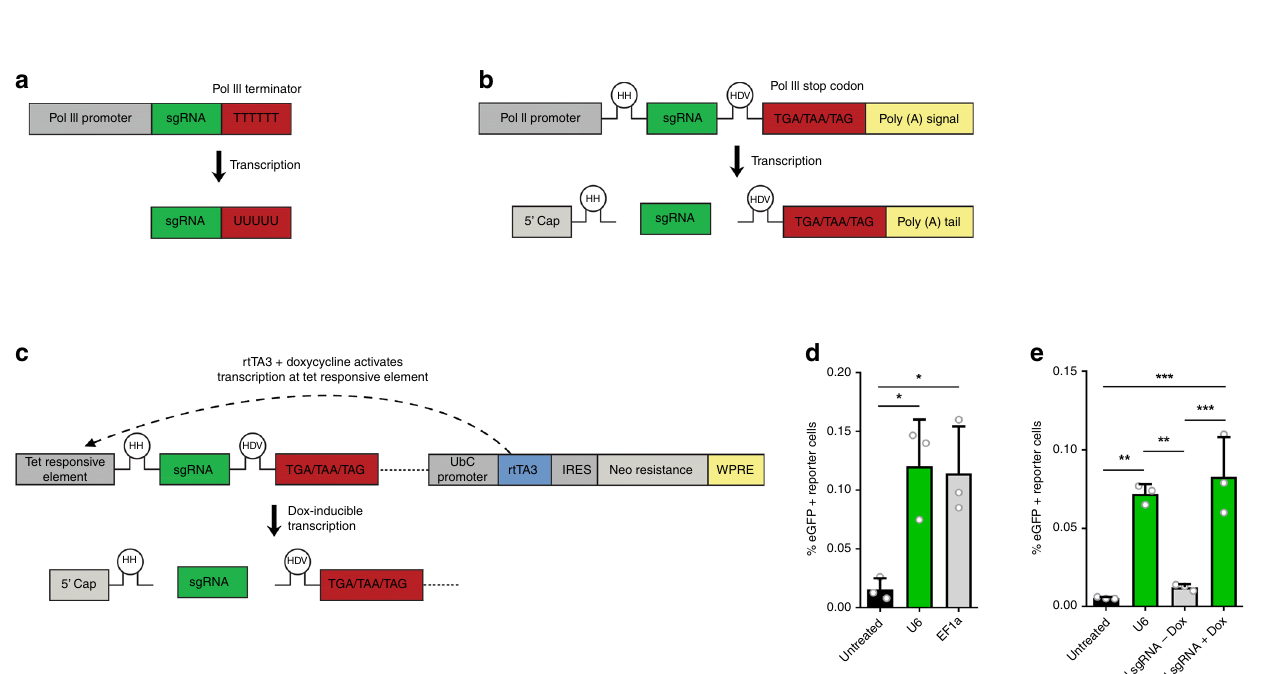
Fig. 5 Incorporation of self-cleaving RNA ribozymes allows the use of Pol II-mediated donor cell sgRNA expression in the CROSS-FIRE system. a Standard expression of sgRNAs under a Pol III promoter. Transcription is ended by a Pol III terminator sequence; TTTTTT. The expressed sgRNA is not subjected to any additional post-transcriptional modi fi cations under a Pol III promoter. b Incorporation of self-cleaving Hammerhead (HH) and Hepatitis Delta Virus (HDV) RNA ribozymes sequences fl anking the sgRNA sequence expressed under a Pol II promoter results in the removal of